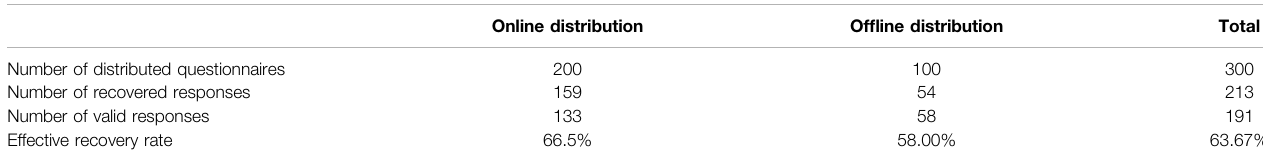
TABLE 1 | Recovery means and statistics on the recovered samples.